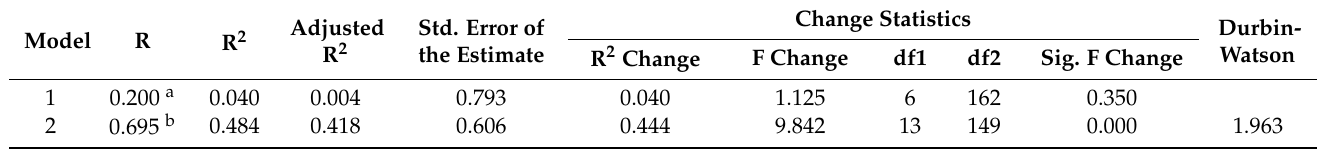
Table 4. Influence of temperature, air, and light on comfort (Model